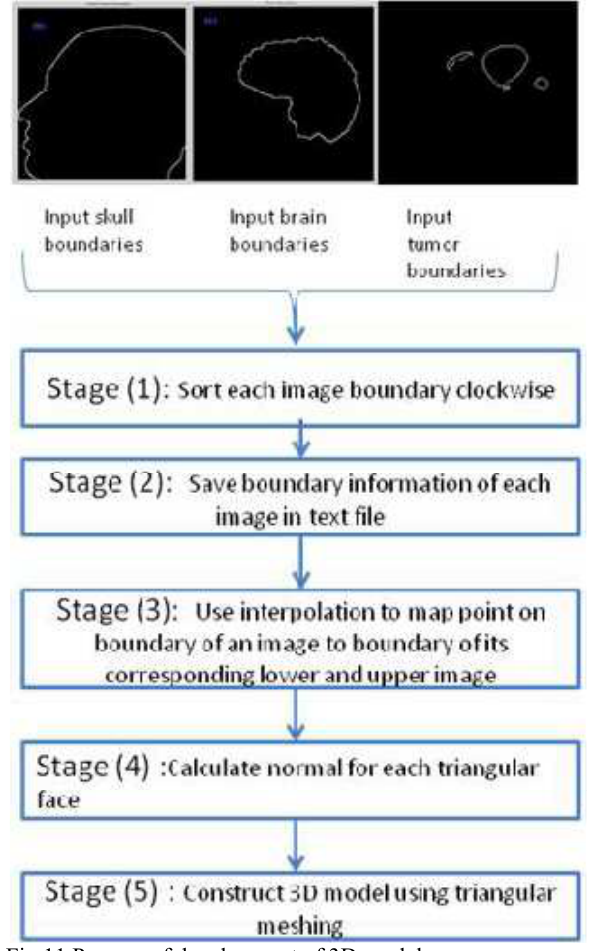
Fig.11 Process of development of 3D